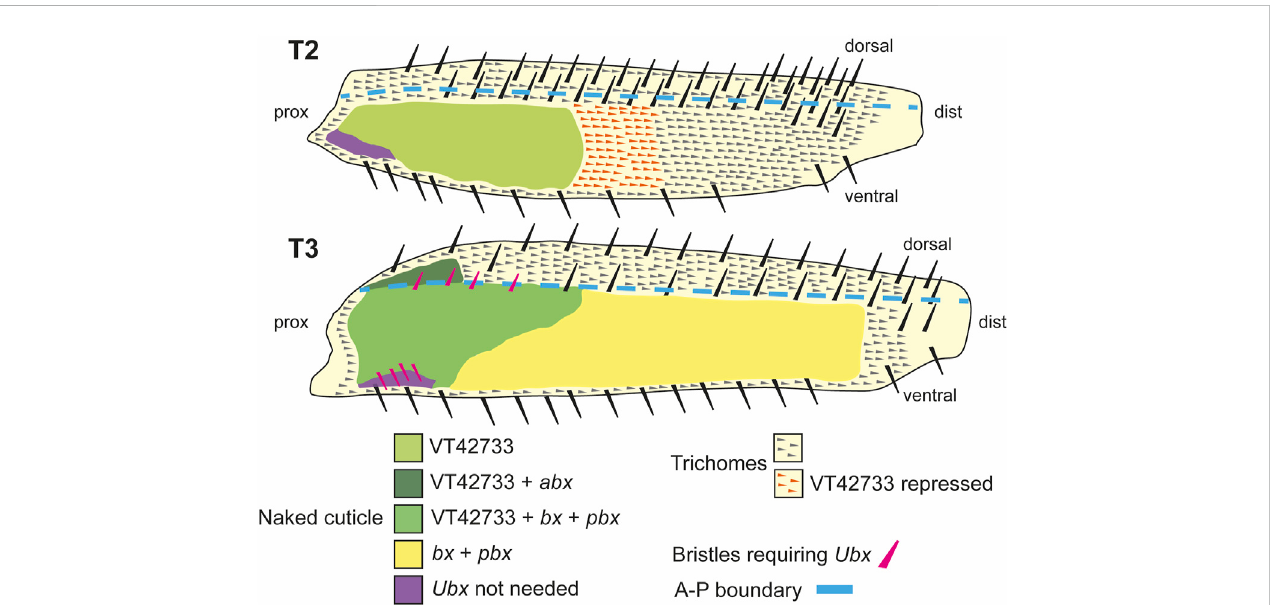
FIGURE 7 Summary of the regulation and roles of Ubx in T2 and T3 femurs. In T2 (upper scheme), Ubx expression is regulated in the proximal posterior femur by enhancer VT42733 and, together with the co-factors Exd and Hth, results in the activation of miR-92a/b and suppressionof trichomes in theso called “ naked valley ” (light green). Repression of Ubx via VT42733 (potentially regulated by awh , C15 , Dll , mirr or NK7.1 ) more distally in the T2 posterior femur de fi nes the distal limit of Ubx expression and the “ naked valley ” (orange trichomes). In T3 (lower scheme), VT42733 and abx regulate Ubx expression in the proximal dorsal-anterior of the femur to suppress trichome development (dark green). This also requires vvl . In the posterior T3 femur, Ubx expression requires VT42733, bx and pbx proximally (medium green), and bx and pbx distally (yellow) tosuppresstrichomesand generate nakedcuticle.Patterning oftheanterior andposteriorT3femurby Ubx alsorequires exd and hth .ThecorrectdevelopmentofsmallproximalbristlesontheT3posteriorfemuralso requires Ubx (pink bristles). In the proximal posterior-ventral femurs of both T2 and T3, trichome development is blocked independently of Ubx (purple shading). Scheme based on fi ndings of Stern (1998), Stern (2003), Davis et al. (2007) and this